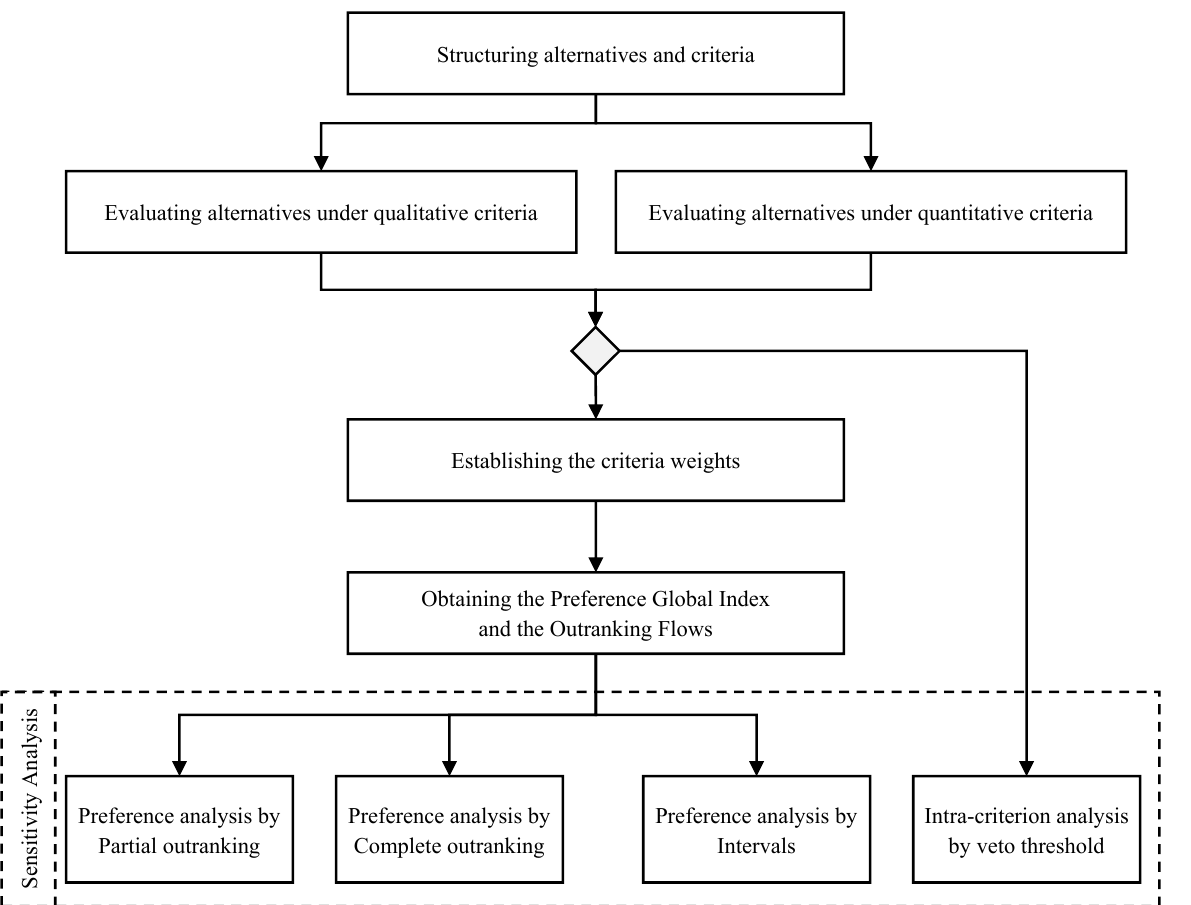
Figure 1. Steps of the modeling PROMETHEE-SAPEVO-M1.